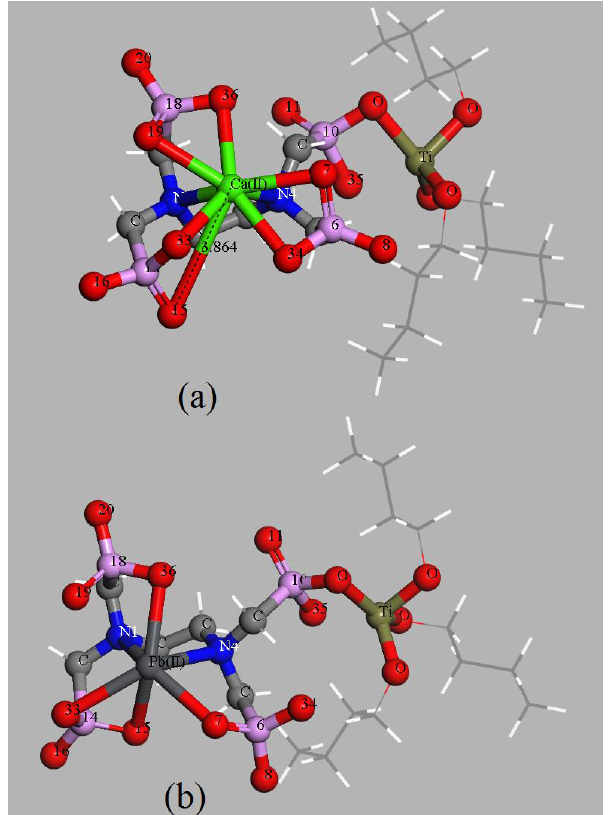
Figure 9. Optimized structures of [Ca(II)-(EDTMPA-TBOT)] 5− and [Pb(II)-(EDTMPA-TBOT)] 5− complexes with